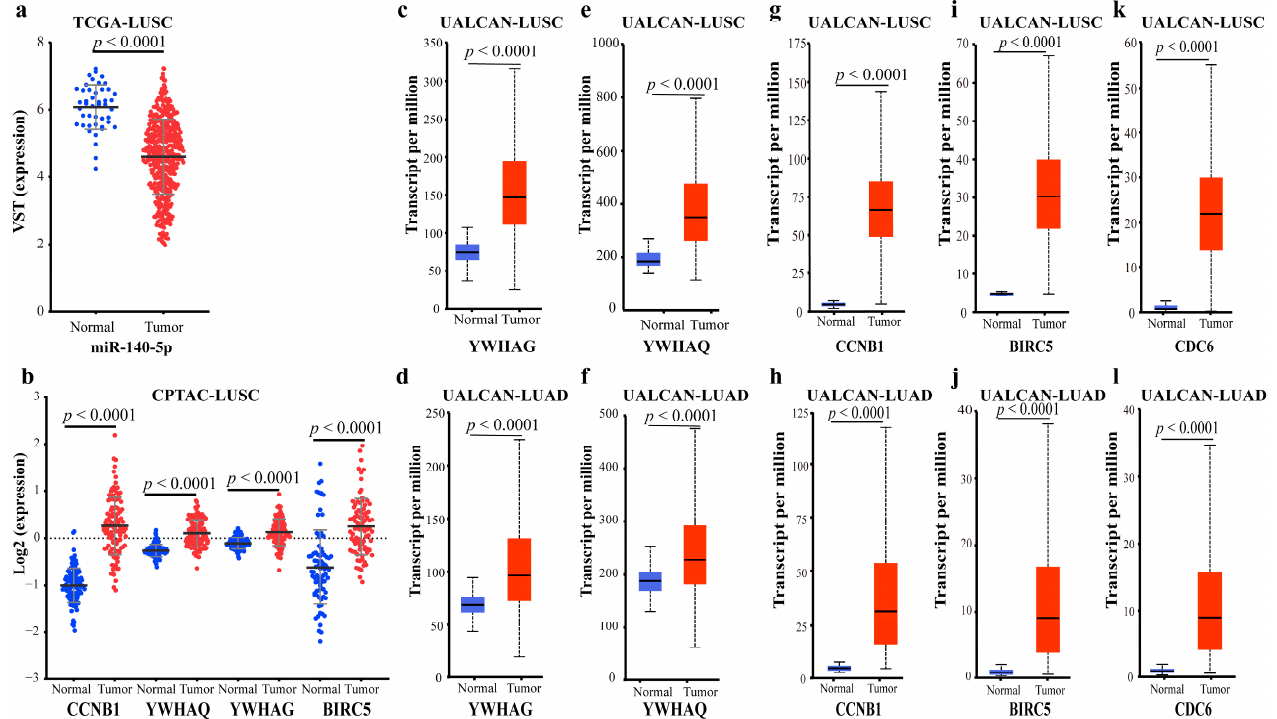
Figure 20. Expression data of miR-140-5p and related proteins: ( a ) MiR-140-5p expression data of LUSC in TCGA; ( b ) Proteome expression data of CCNB1 , YWHAQ , YWHAG , and BIRC5 of LUSC in CPTAC; ( c ) YWHAG mRNA expression data of LUSC in UALCAN; ( d ) YWHAG mRNA expression data of LUAD in UALCAN; ( e ) YWHAQ mRNA expression data of LUSC in UALCAN; ( f ) YWHAQ mRNA expression data of LUAD in UALCAN; ( g ) CCNB1 mRNA expression data of LUSC in UALCAN; ( h ) CCNB1 mRNA expression data of LUAD in UALCAN; ( i ) BIRC5 mRNA expression data of LUSC in UALCAN; ( j ) BIRC5 mRNA expression data of LUAD in UALCAN; ( k ) CDC6 mRNA expression data of LUSC in UALCAN; ( l ) CDC6 mRNA expression data of LUAD in UALCAN.